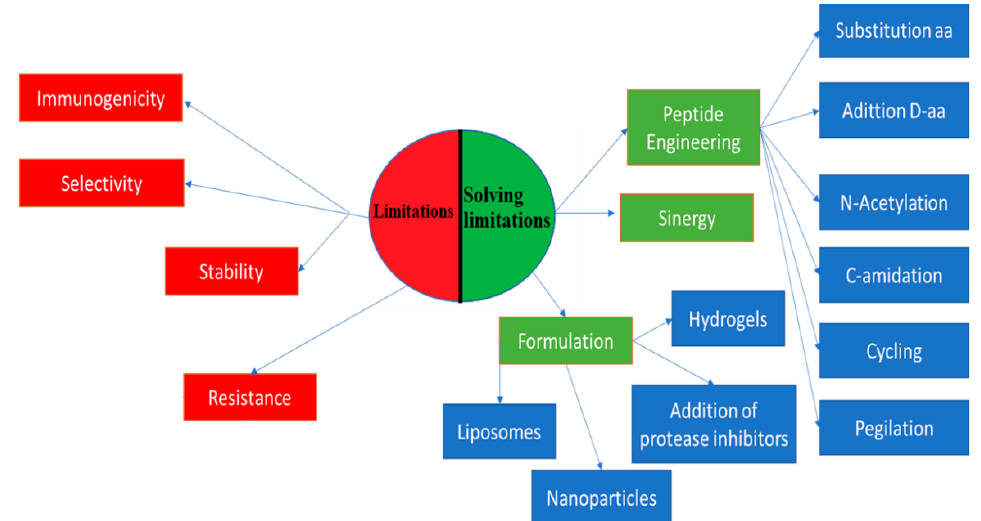
Figure 1. Peptide limitations and how to overcome them. [10,22,23,26,27]. On the left side there are four limitations to working with peptides which are in red. In green on the right side the three main strategies to mitigate the limitations are shown and also the more specific strategies broken down in each of them in blue.